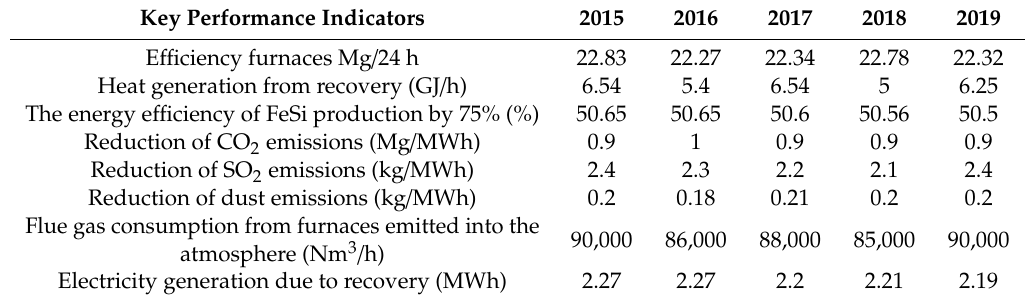
Table 4. E ffi ciency of the energy recovery system (calculation for 2015–2019).